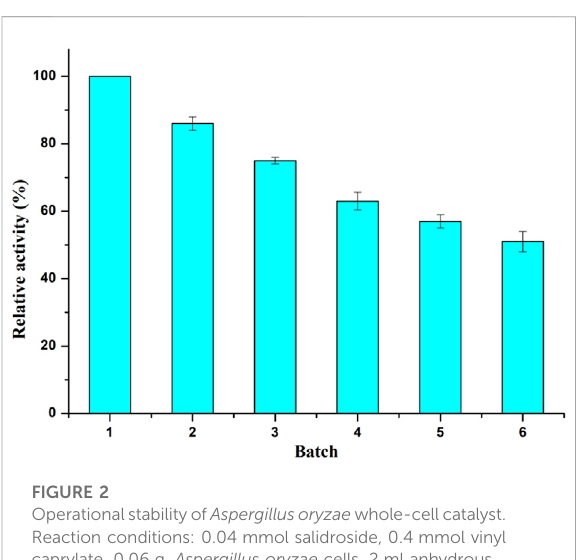
FIGURE 2 Operationalstabilityof Aspergillusoryzae